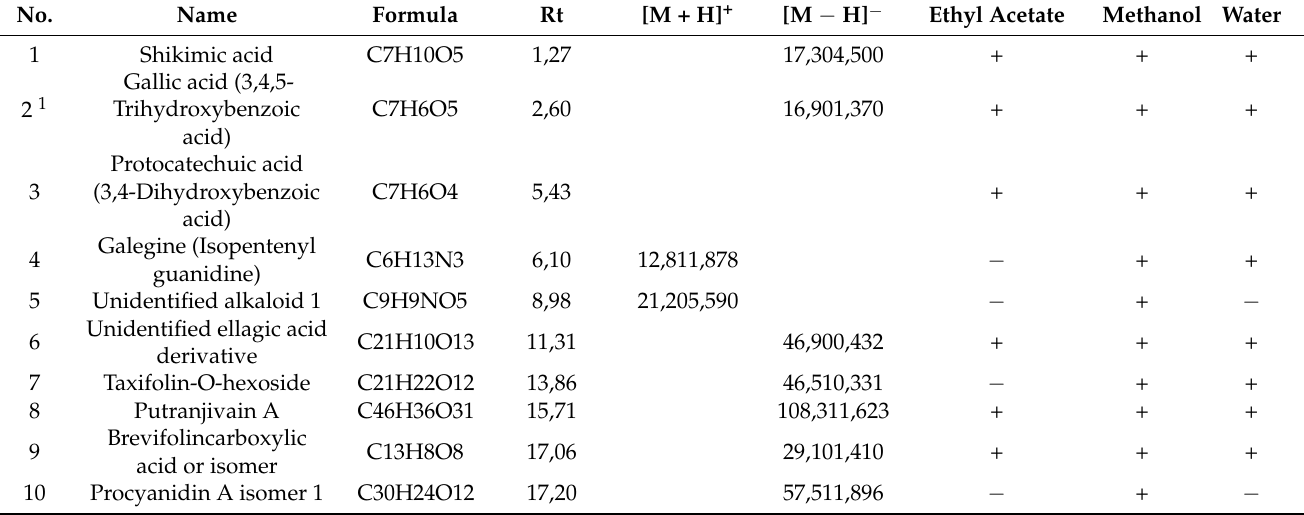
Table 2. Chemical composition of Alchornea cordifolia